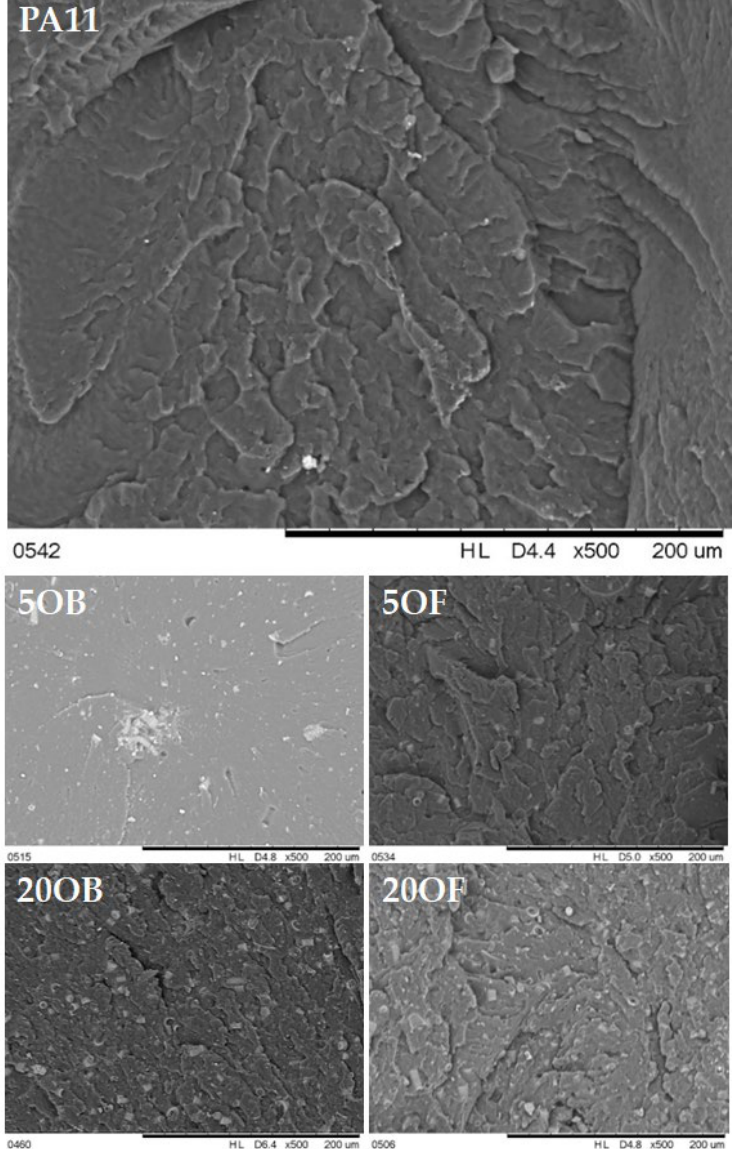
Figure 12. SEM images of biocomposite fractures.